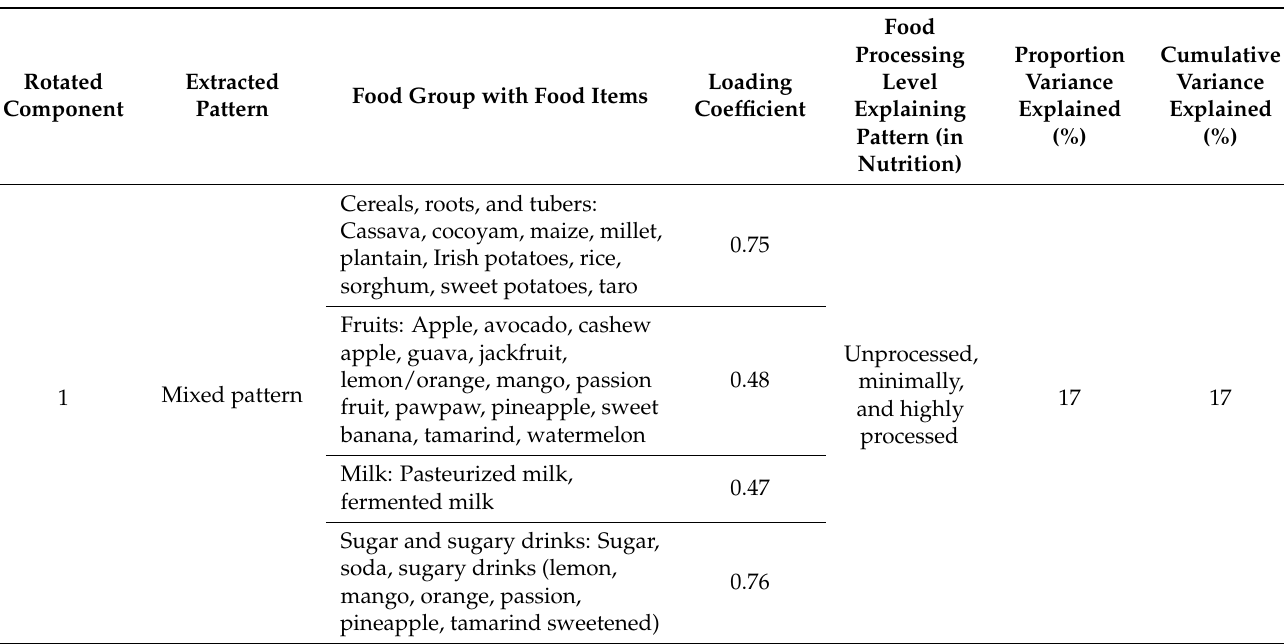
Table 6. Patterns extracted for women of reproductive age in East Africa based on 11 food groups and characterized by three food processing categories.